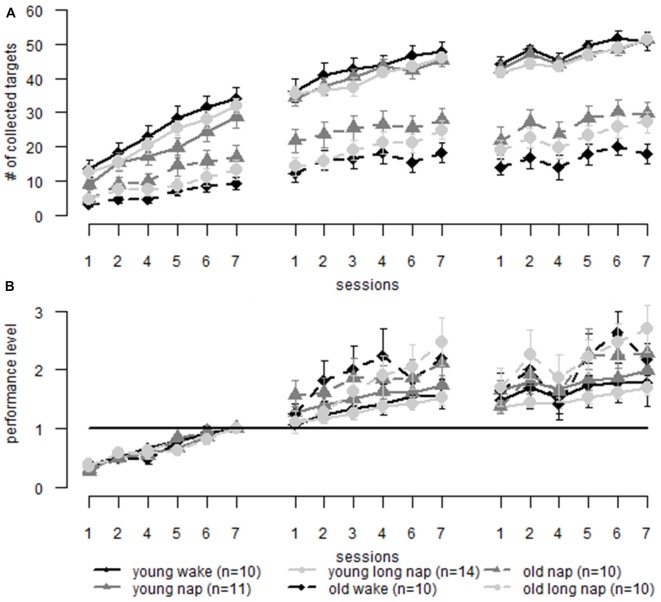
Motor adaptation: comparison of learning in older (dotted lines) and younger adults (solid lines) over three learning sessions including a midday break (first gap) and over-night sleep (second gap). (A) Raw data comparing young and older adults. (B) Data is normalized to the same pre-sleep level of learning. When the initial learning phase is eliminated the learning curves are similar to older and younger adults. Older adults show greater performance improvements than younger adults. Error bars represent the standard error of the mean.